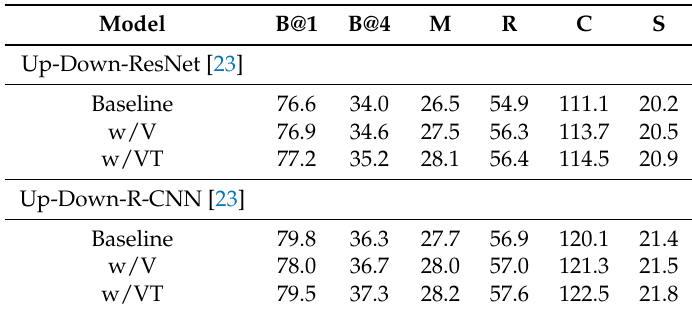
Table 3. Experiment results on the Up-Down model with different kind of information sources trained by the reinforcement learning